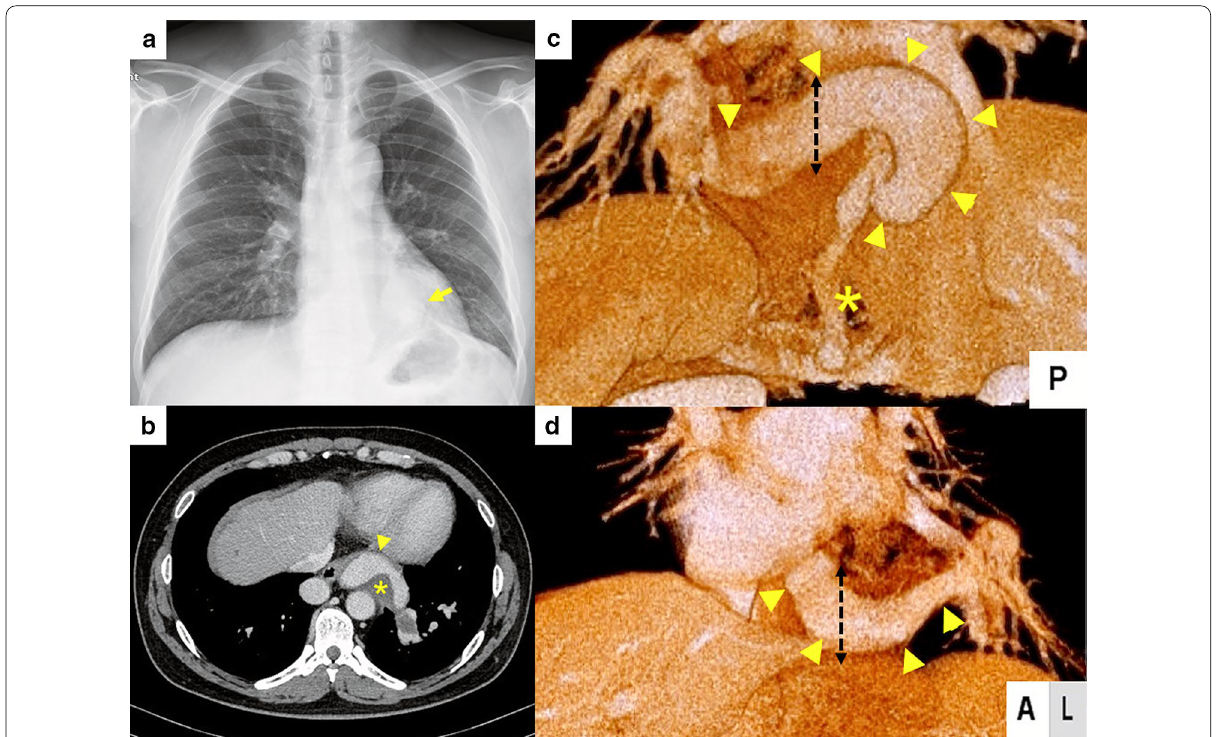
Fig. 1 Preoperative chest X-ray and computed tomography images. a Chest X-ray image showing abnormal consolidation in the left lower lung field (yellow arrow). b Enhanced computed tomography revealed the presence of an aberrant artery with a maximum diameter of 33 mm (yellow arrowheads) with a thrombosed lumen (asterisk). c Three-dimensional computed tomography from posterior view revealed an aneurysmal aberrant artery (yellow arrowheads) arising from the celiac artery. We resected the aberrant artery with pulmonary ligament (black dotted line). After surgery, we performed coil embolization on the residual aberrant artery (asterisk). d Three-dimensional computed tomography from anterior view showed that the aneurysmal aberrant artery (yellow arrowheads) arose from the celiac artery and was flowing into the left lower lobe along the pulmonary ligament forming an aneurysm. It was divided along with the pulmonary ligament (black dotted